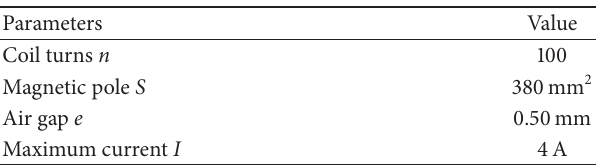
Table 1: Parameter of electromagnet.